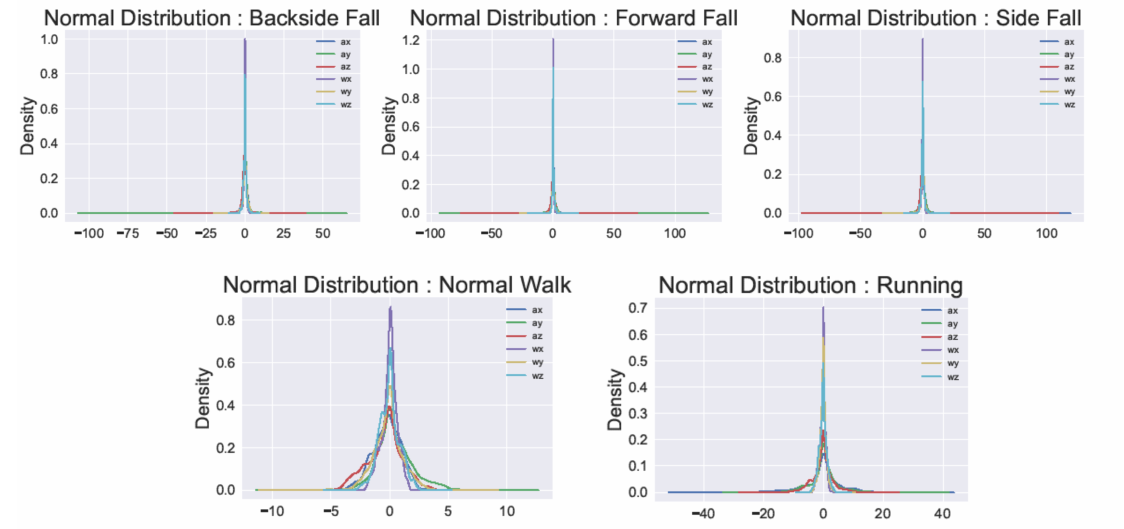
Figure 3. Normal distribution of the obtained accelerometer and gyroscope